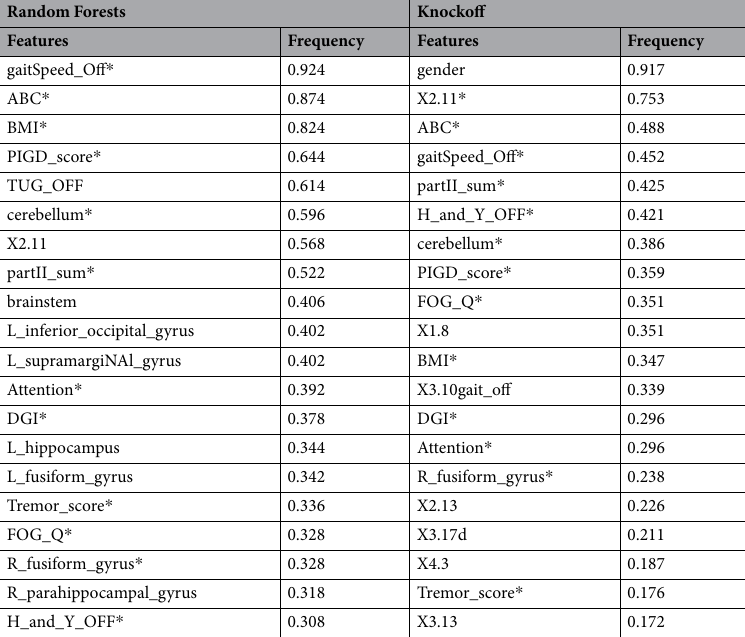
Table 6. 13 features ( * ) are selected by both methods (RF and KO): gaitSpeed_Off, ABC, BMI, PIGD_score, cerebellum, X2.11, partII_sum, Attention, DGI, Tremor_score, FOG_Q, R_fusiform_gyrus,